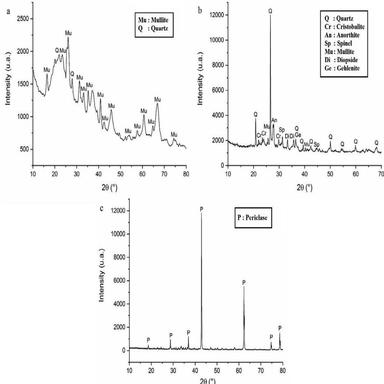
Phase composition analysis by XRD of the elaborated ceramics at different temperatures: (a): Kaolinitic clay at 1400 C; (b): Illitic clay at 1200 C; (c): Magnesite at 1300 C.